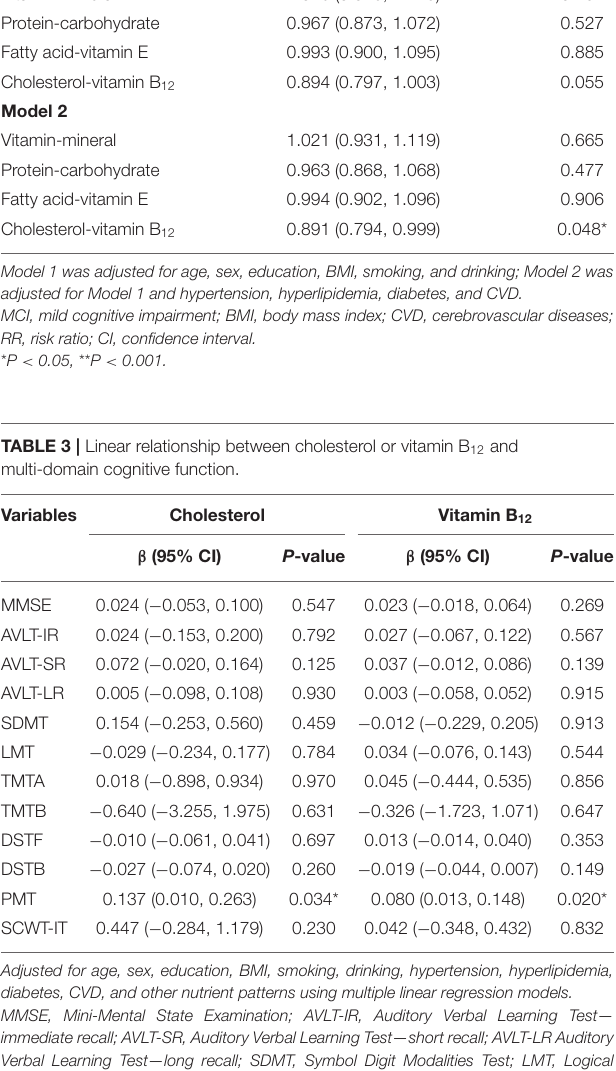
( Figure 2 ). No dose-response relationship between cholesterol and multi-domain cognitive function was found.